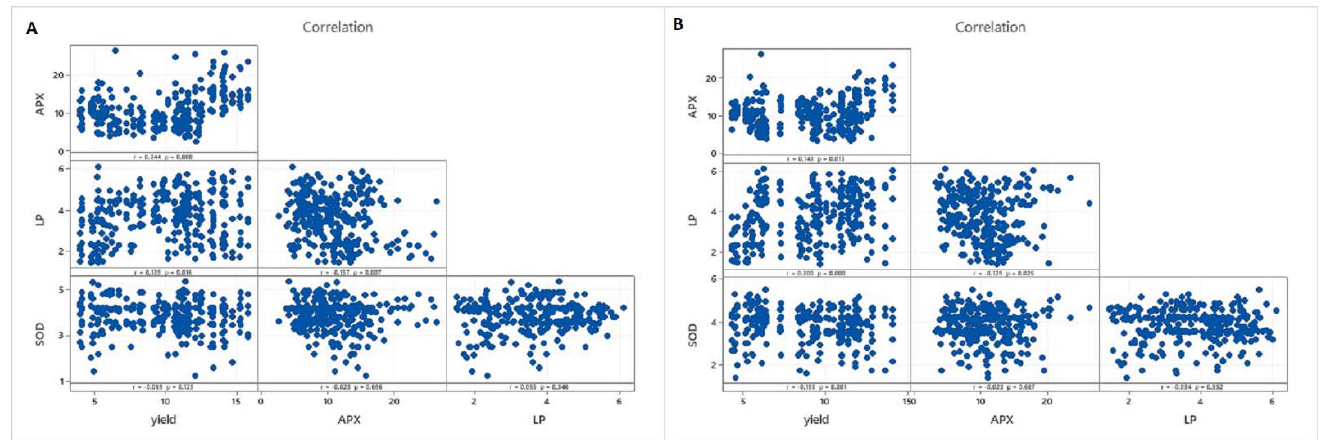
Figure 3. Correlation analysis ( A ): correlation between N fertilizer and indices, ( B ): correlation between NPK fertilizer and indices. (Ascorbate peroxidase (APX), lipid peroxidation (LP), superoxide dismutase (SOD)) (N = 1881) (Blue dots: Points related to two variables).